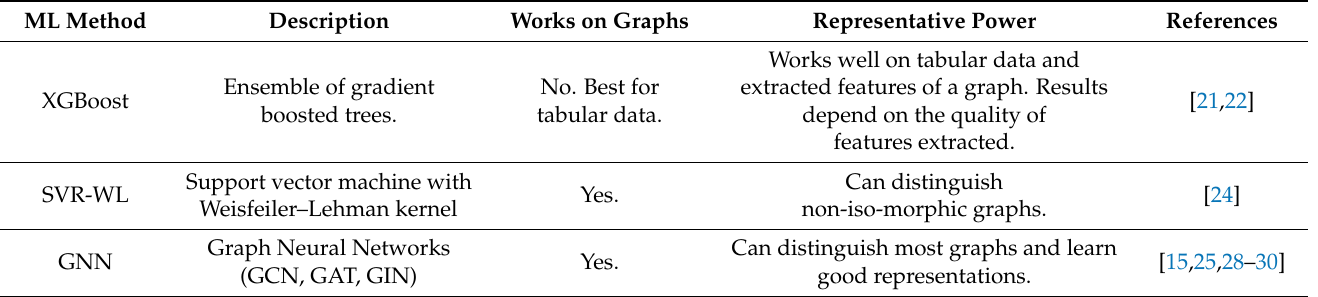
Table 1. Different machine learning methods